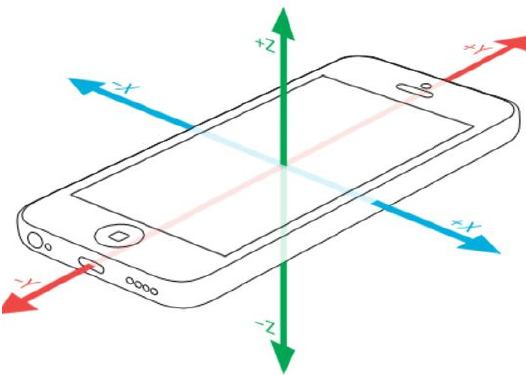
Figure 2. Mobile phone three-axis coordinate system.